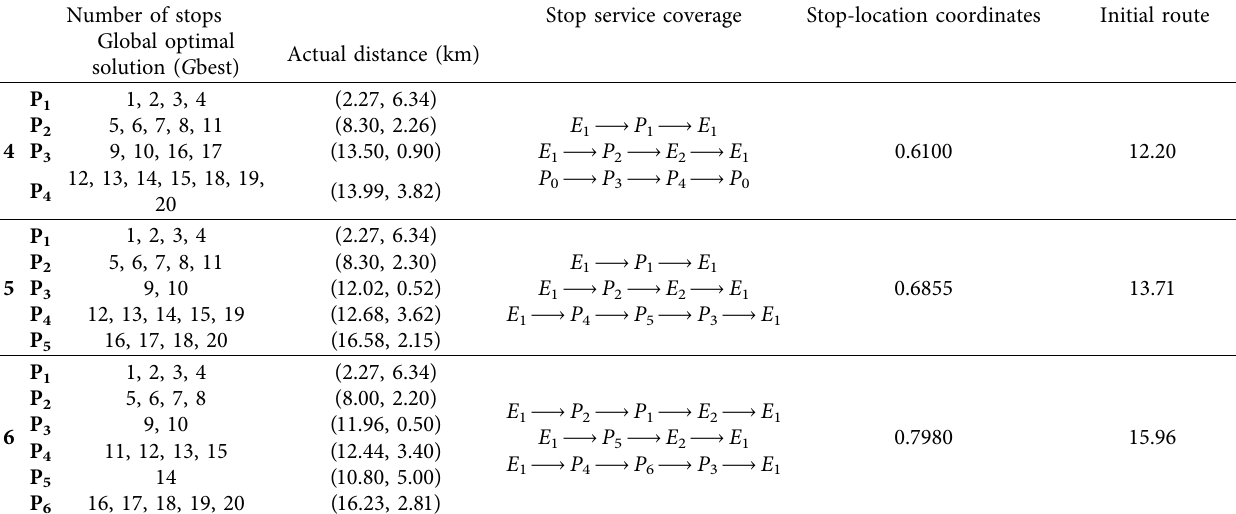
Table 8: Comparative analysis for different numbers of